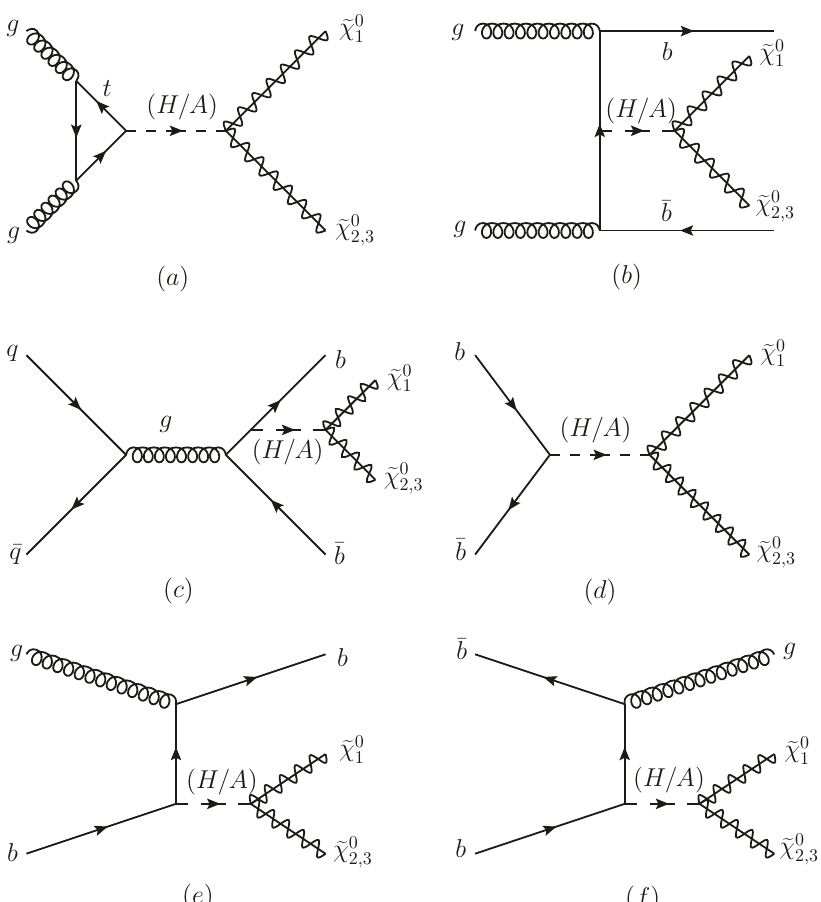
Figure 13. The Feynman diagram of signal processes from (a) gg fusion process; 4F (b) gg → b ¯ bH and (c) q ¯ q → b ¯ bH production; 5F (d) b ¯ b → H (LO), (e) gb → bH and (f) b ¯ b → gH